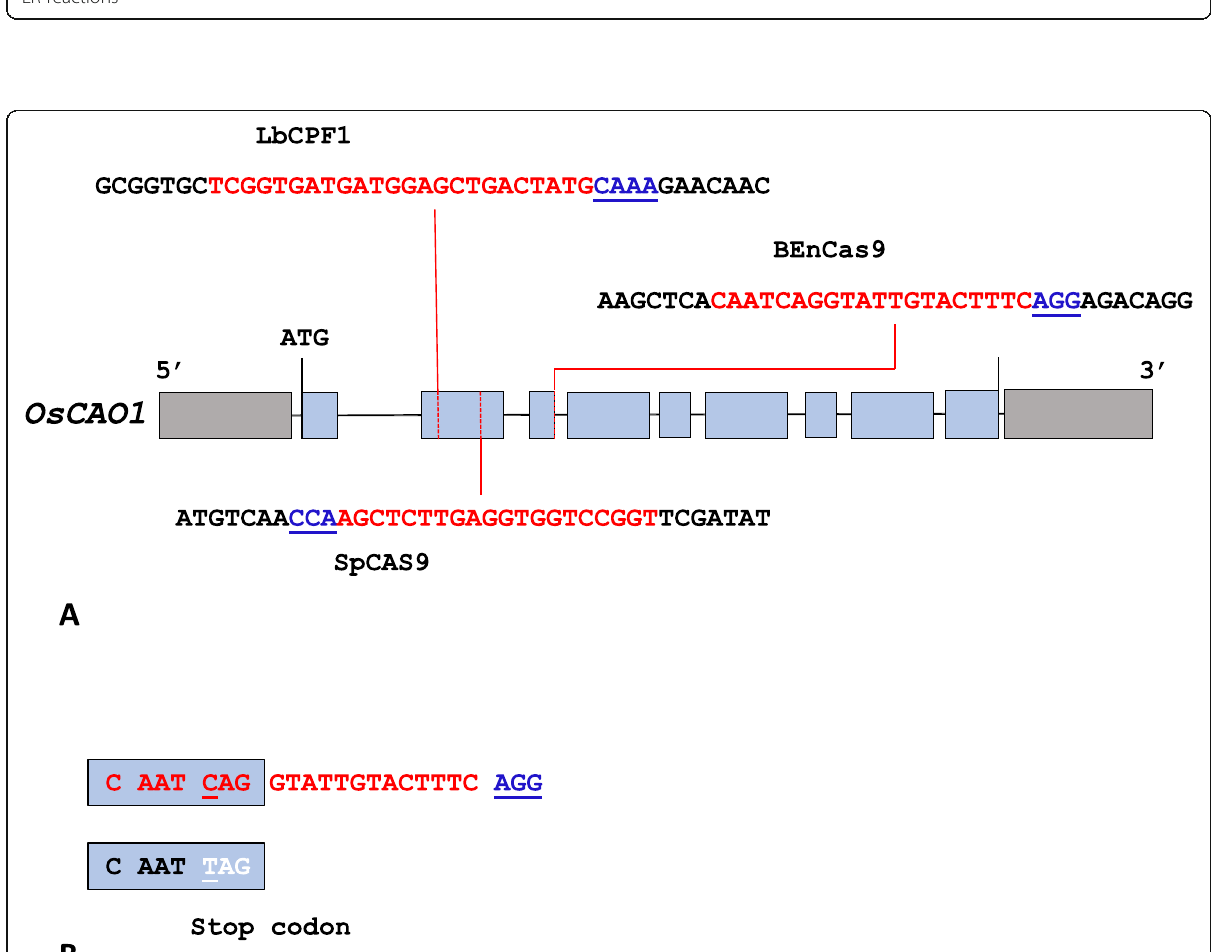
Fig. 2 Positions and sequences of the spacers used. A) Positions of spacers and associated sequences relative to the OsCAO1 gene. PAM (CAAA (TTTN PAM on complementary strand) for LbCPF1, CCA for CAS9 (TGG (NGG on complementary strand)) and AGG for BECAS9) are shown in blue, spacers are in red, and genomic sequences are in black. B) Theoretical mutation introduced by a C- > T transversion by BECAS9, which leads to the replacement of the C nucleotide of the CAG splicing site by a T nucleotide and introduces a stop codon (TAG) instead of the amino acid